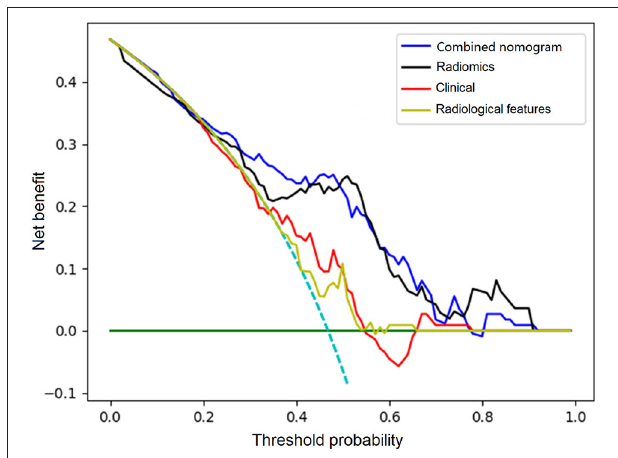
FIGURE 4 | Comparison of decision curves analysis for clinical features, radiological features, combined radiomics features, and the constructed nomogram for prediction of stroke recurrence in